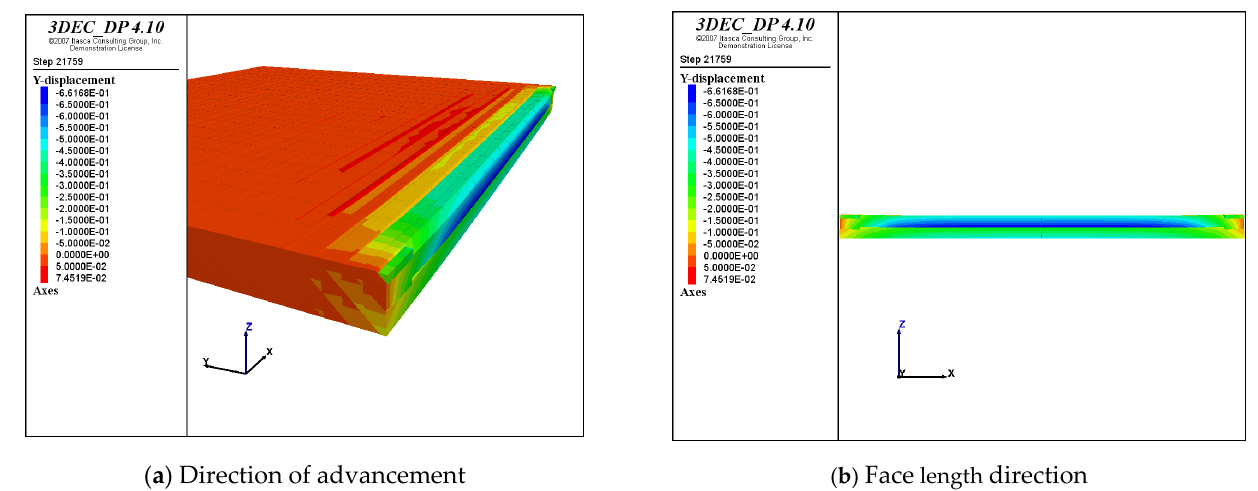
Figure 19. Y-displacement nephogram ( α sj = 45°, d = 2 m). When the spacing between the joints is 5 m, there is one intersection line between the joints and the working face, and the position of the intersection line in the working face changes continuously with the advance of the working face (Figure 14). When the spacing between the joints is 2 m, there are two intersection lines between the joints and the working face, and the position of the intersection line in the working face changes continuously with the advance of the working face (Figure 19). When the spacing between the joints is 1.41 m, there are two intersection lines between the joints and the working face, and the position of the intersection line in the working face does not change with the advance of the working face (Figure 18). This indicates that as the spacing between the joints decreases, the area of the easy working face rib-spalling increases (Figure 20).